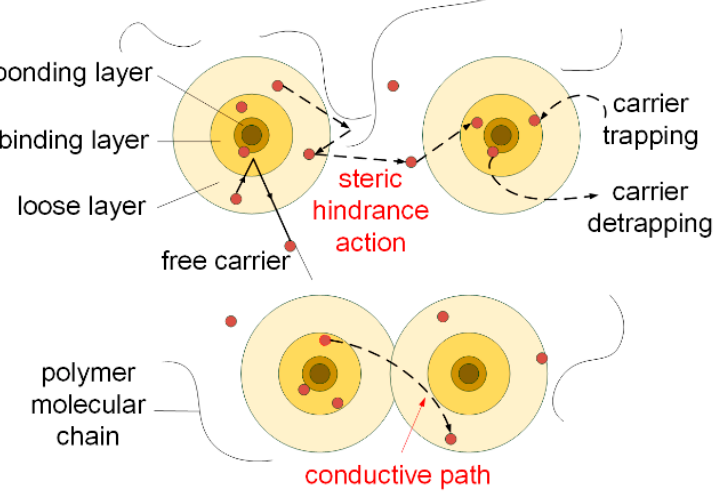
Figure 12. Carrier transport process in nano-ZnO modified polymers based on the multi-core model.